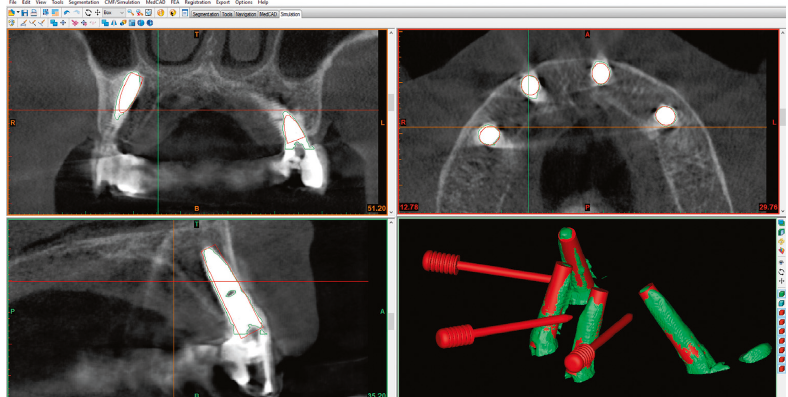
Figure 3: Super imposition of the postop CT scan and the preop 3D